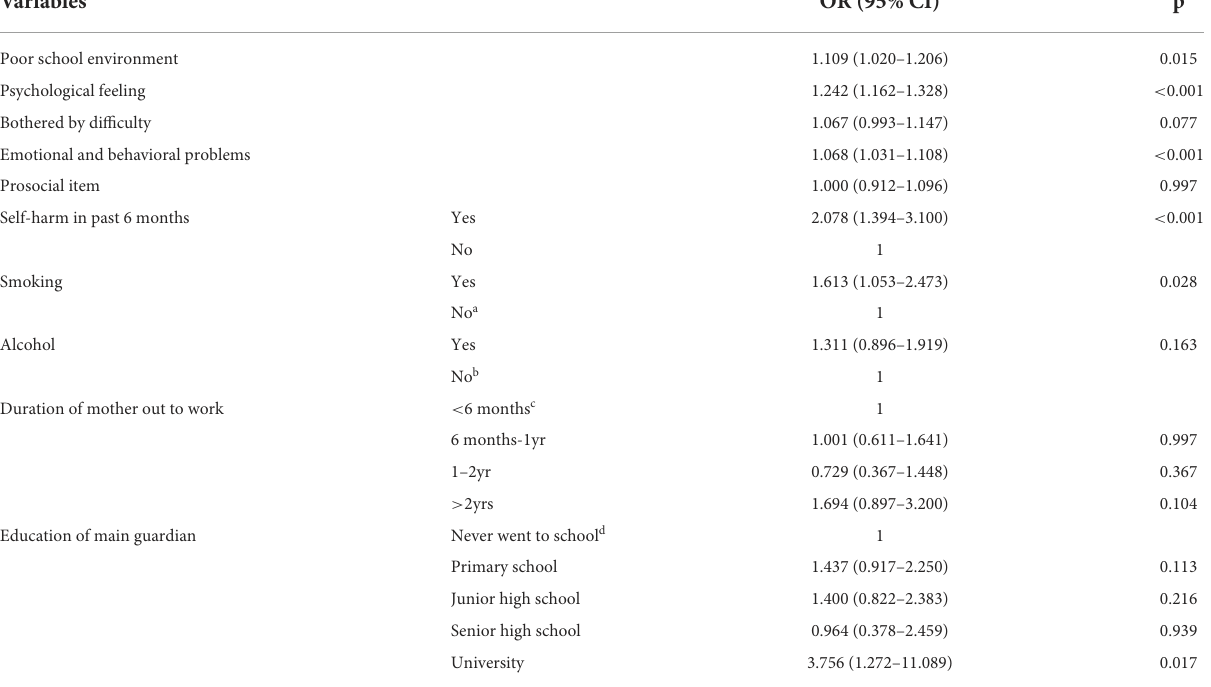
TABLE 6 Correlates emotional and behavioral problems, smoking attempt, previous alcohol use and school environment on suicidal ideation in LBC.